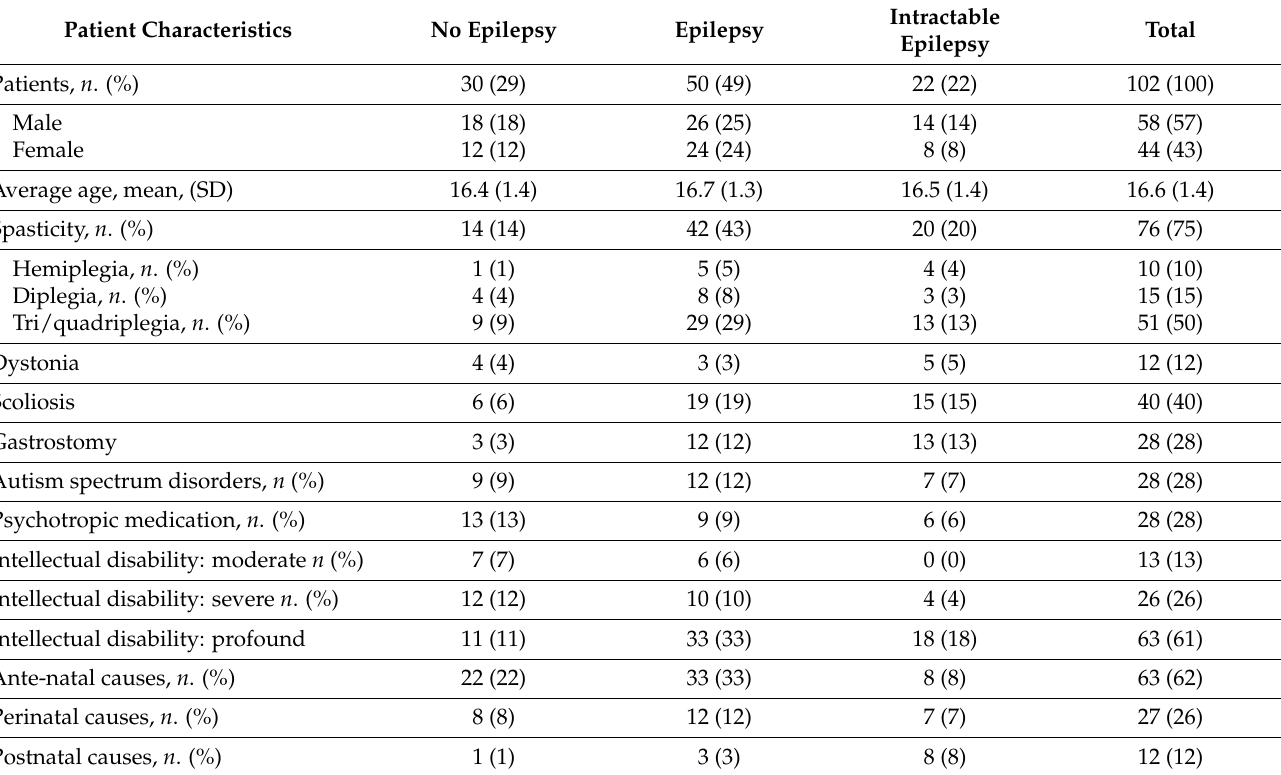
Table 1. Characteristics of participants with the presence and type of